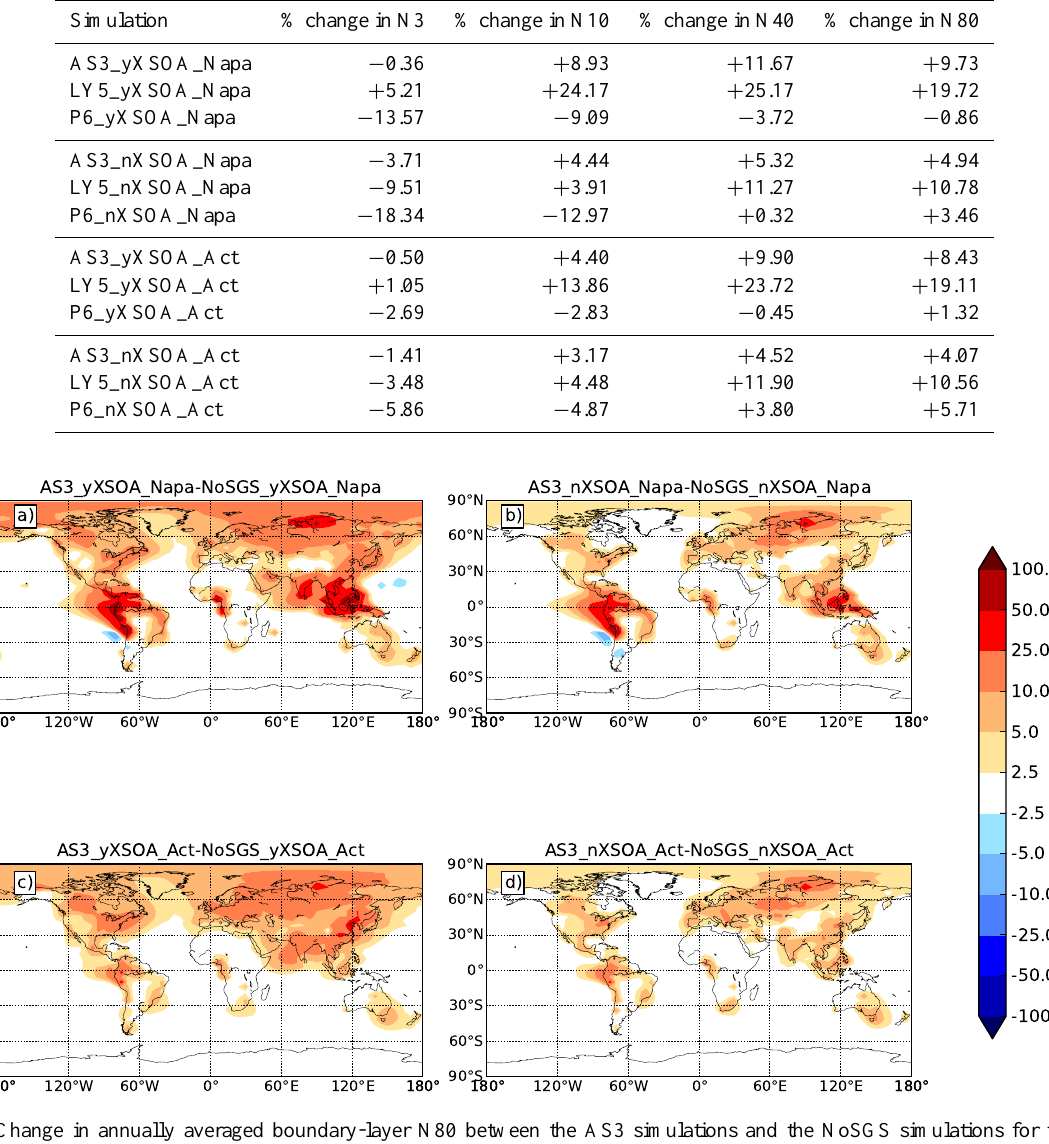
Figure 2. Change in annually averaged boundary-layer N80 between the AS3 simulations and the NoSGS simulations for the (a) yX- SOA_Napa, (b) nXSOA_Napa, (c) yXSOA_Act, and (d) nXSOA_Act